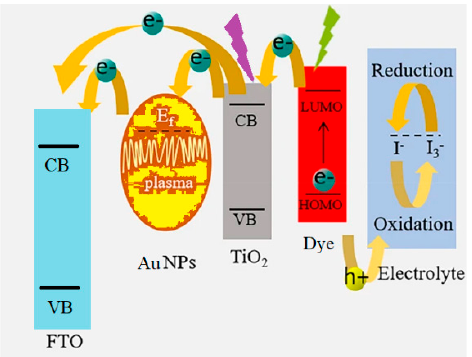
Figure 1. Cross-section view of plasmonic-based dye-sensitized solar